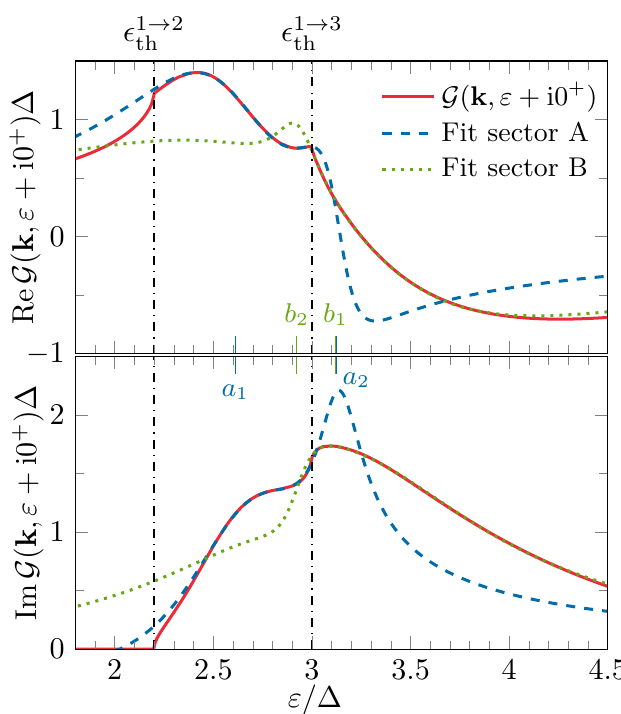
Figure 8: Cross section of the real (top panel) and imaginary (bottom panel) part of the quasiparticle Green’s function at unitarity and ħ hk = 2.16 provide a good fit of the propagator, we split up the energy domain in resonance domains delimited by the threshold energies ε 1 → 2 dotted lines. The fitted function according to Eq. (41) is shown as a blue dashed line below ε 1 → 3 (sector A) and as a green dotted line above (sector B). The real parts of th the eigenenergies found from the fit are indicated on the axis with a ≡ Re z ( B , j ) b j